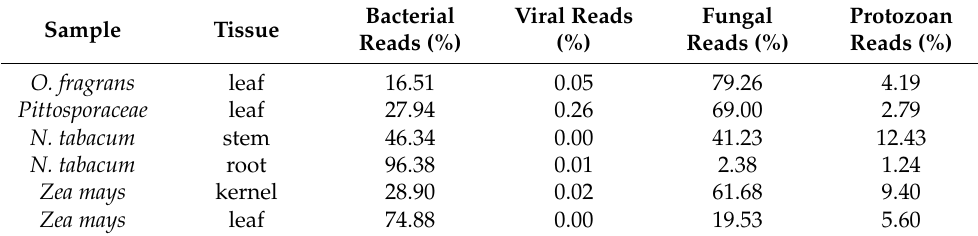
Table 1. Comparison of plant and microbial gene content in samples. Table 2. Content statistics of different microorganisms in